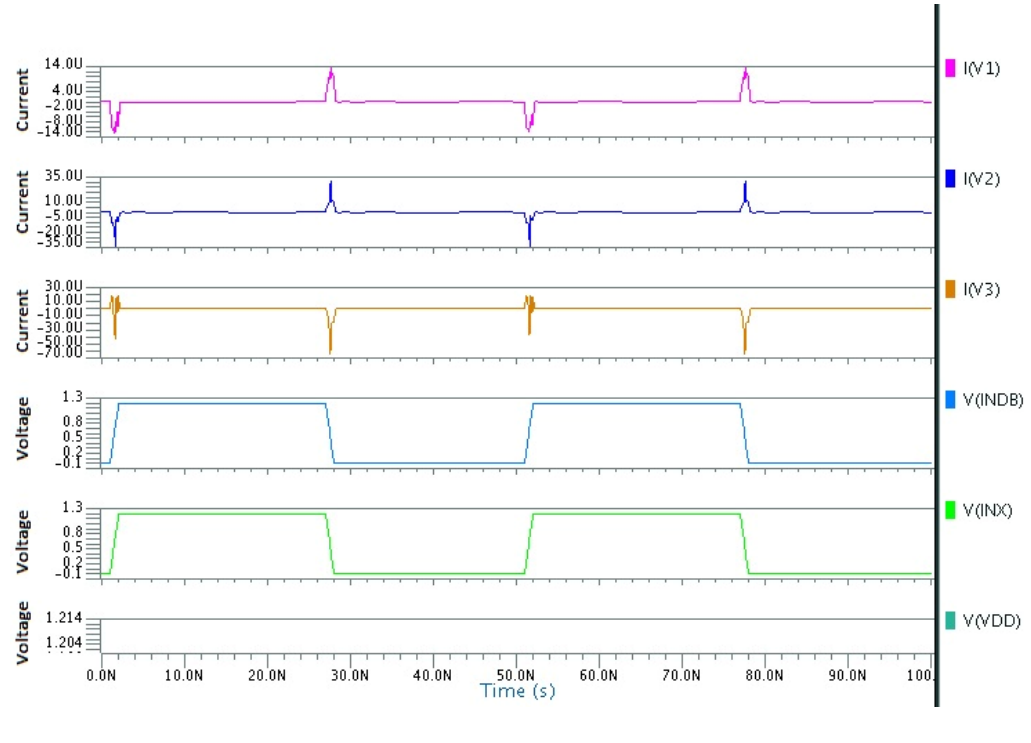
Figure 11. Minimum delay of the proposed FF.